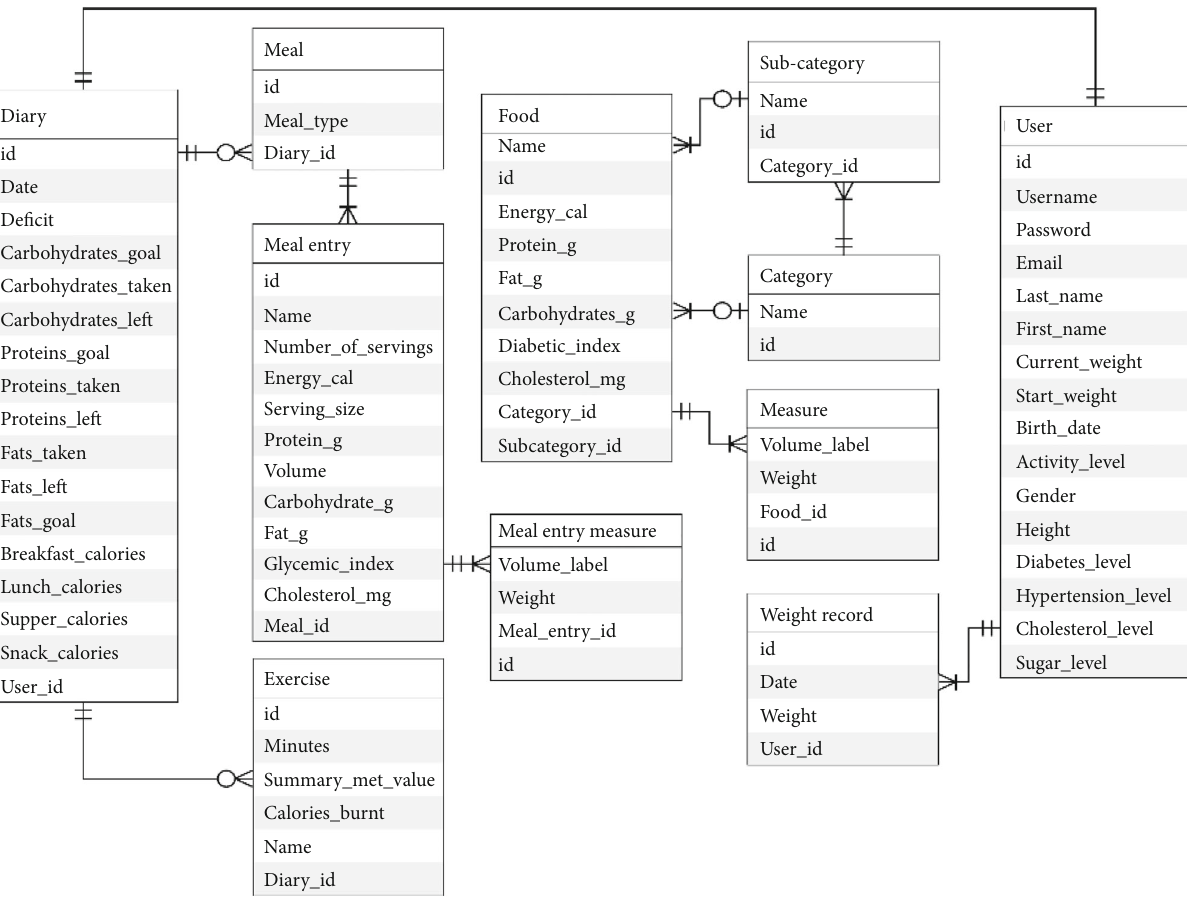
Figure 6: Entity relational diagram for the data relations and